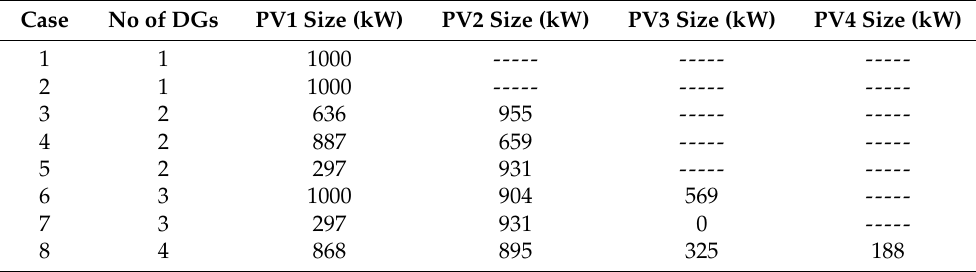
Table 6. Optimal photovoltaic (PV) DG sizes for the IEEE 69-bus test system using GWO.